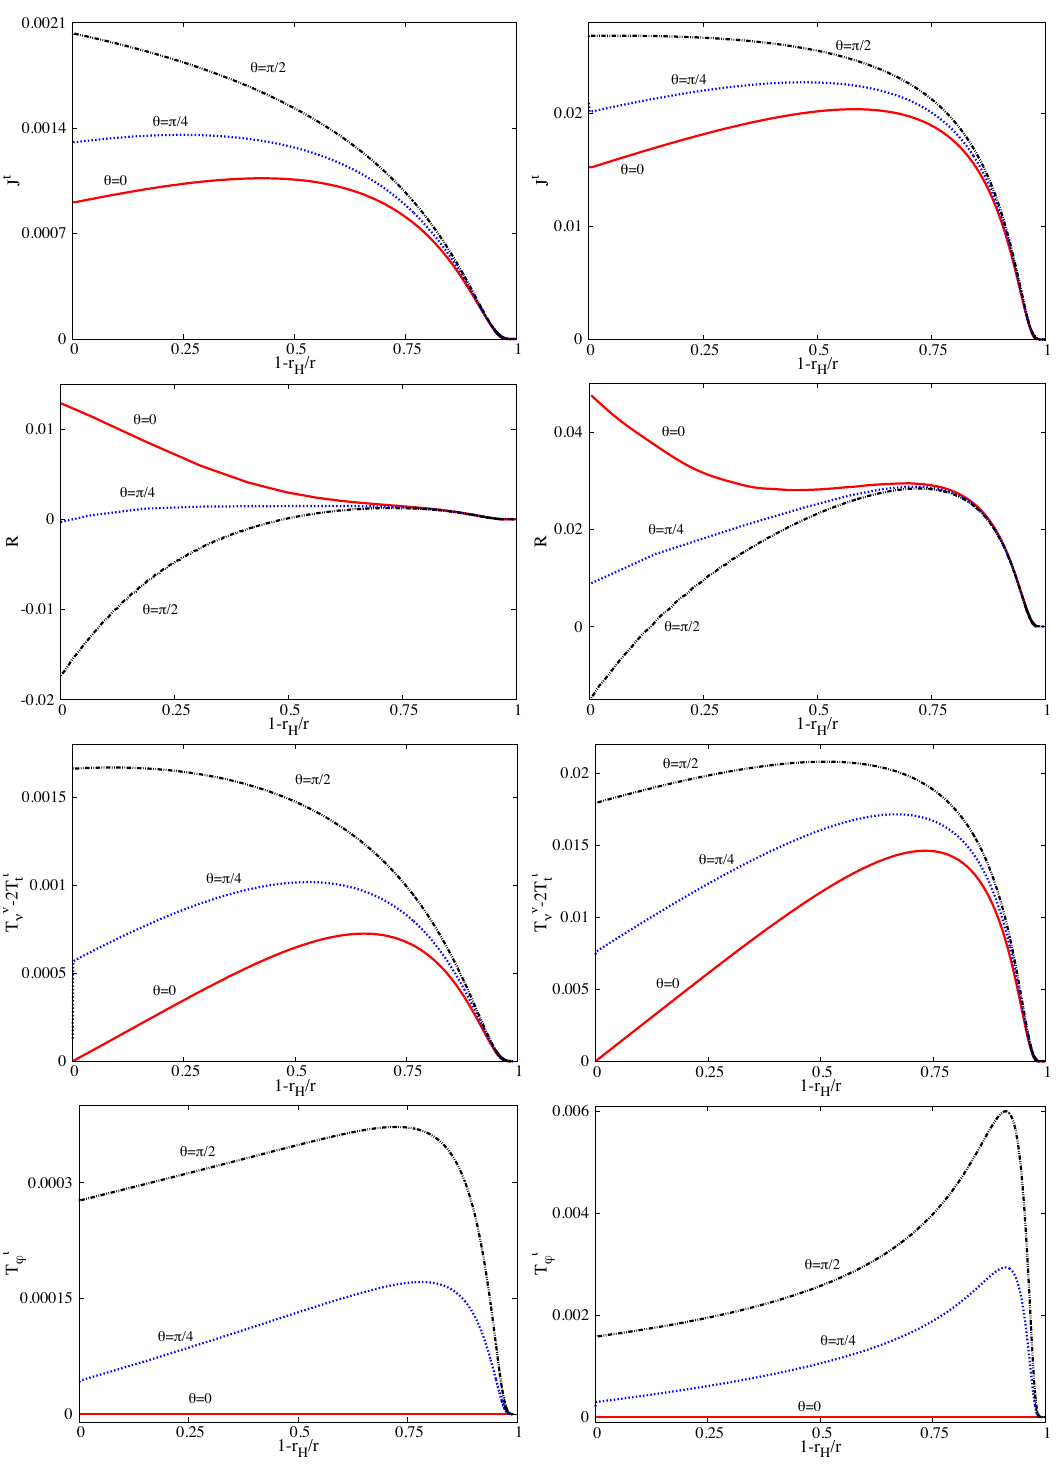
Figure 11 . Some physical quantities for HBH 1 (left panel) and HBH 2 (right panel).